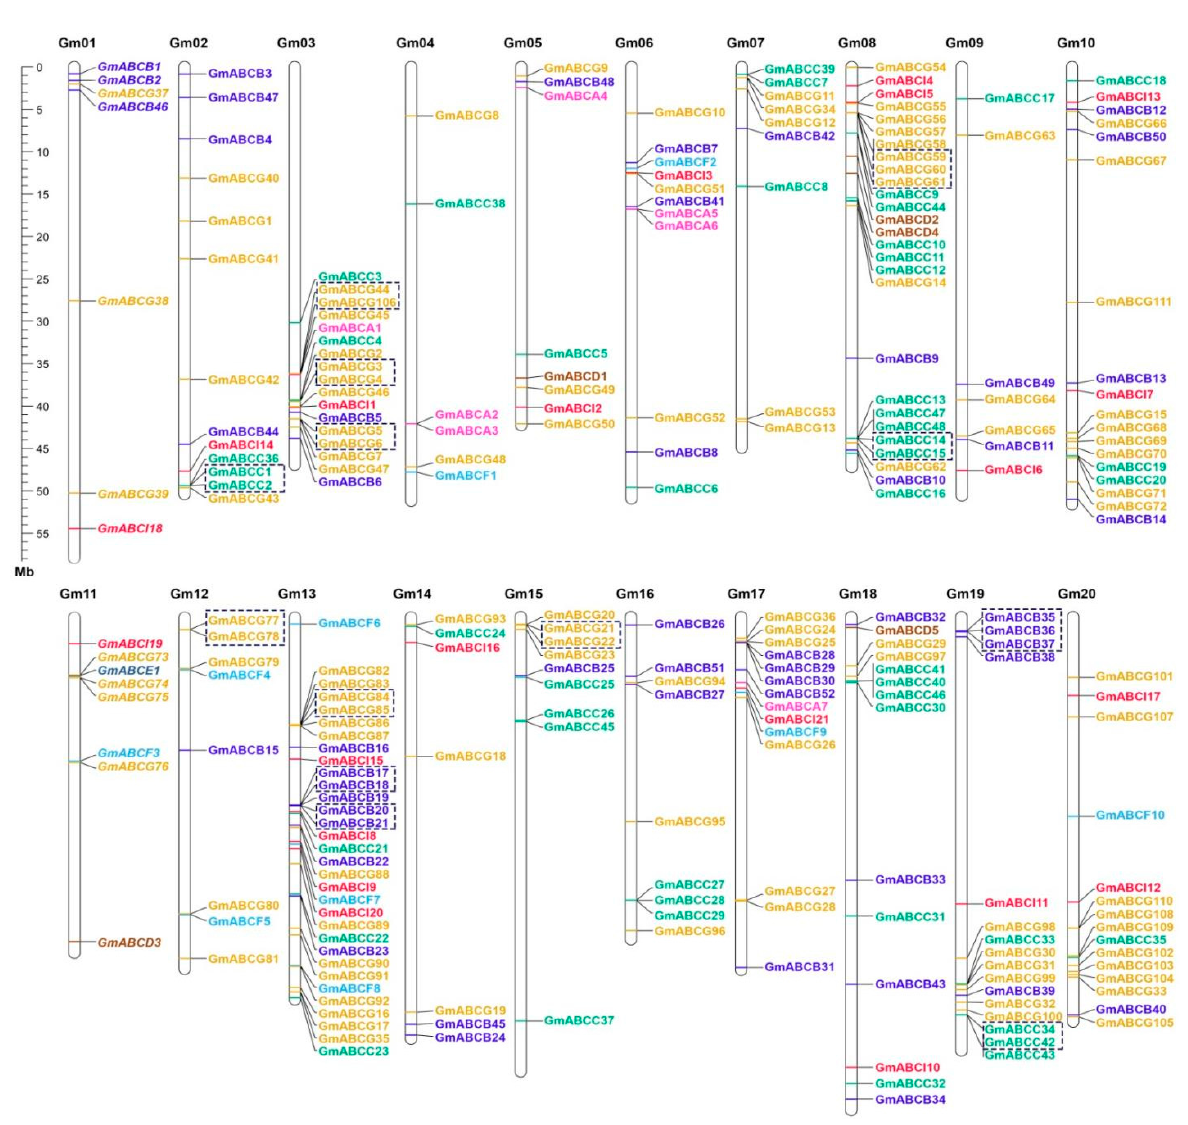
Figure 1. Chromosomal distribution of soybean ABC genes. The chromosome number is indicated at the top of each bar. The scale on the left represents the length in megabases (Mb). The tandemly duplicated GmABC genes are shown in black boxes.